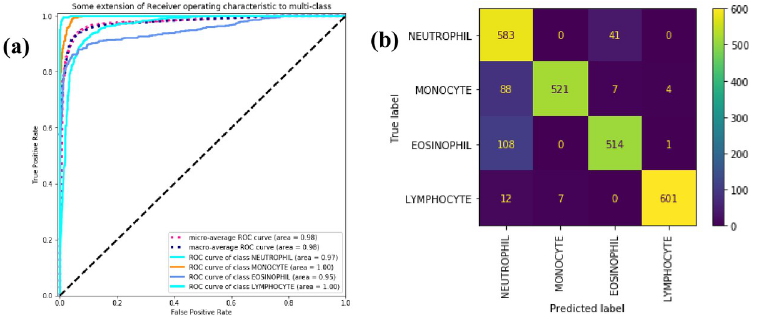
Fig 6. ROC curve and confusion matrix. (a) ROC curve of four subtypes of WBC. (b) Confusion matrix of four subtypes of WBC.